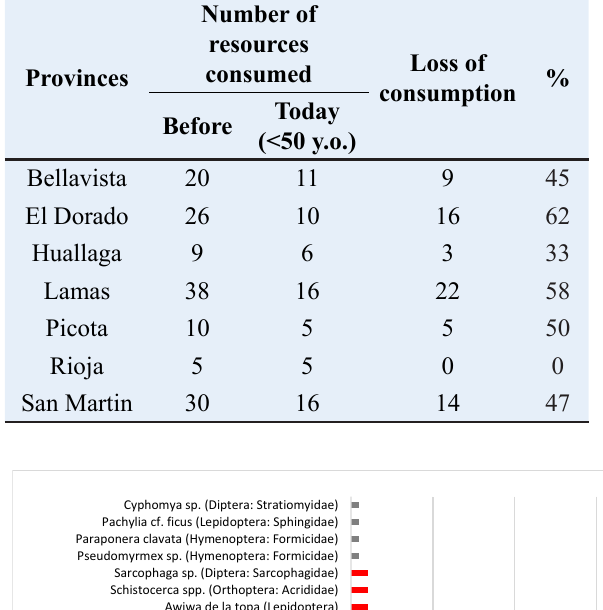
Table 2. Intergenerational loss in the number of species consumed in seven provinces of San Martin